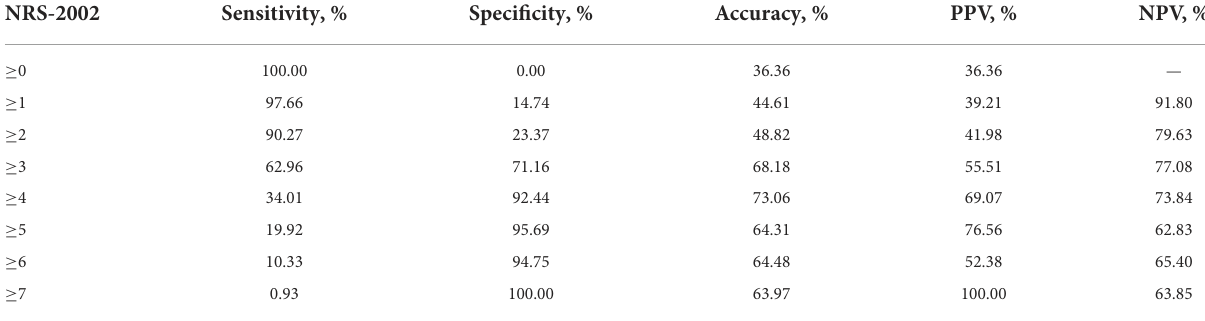
TABLE 4 The predictive value of nutritional risk screening 2002 for stroke associated infection in patients with ischemic